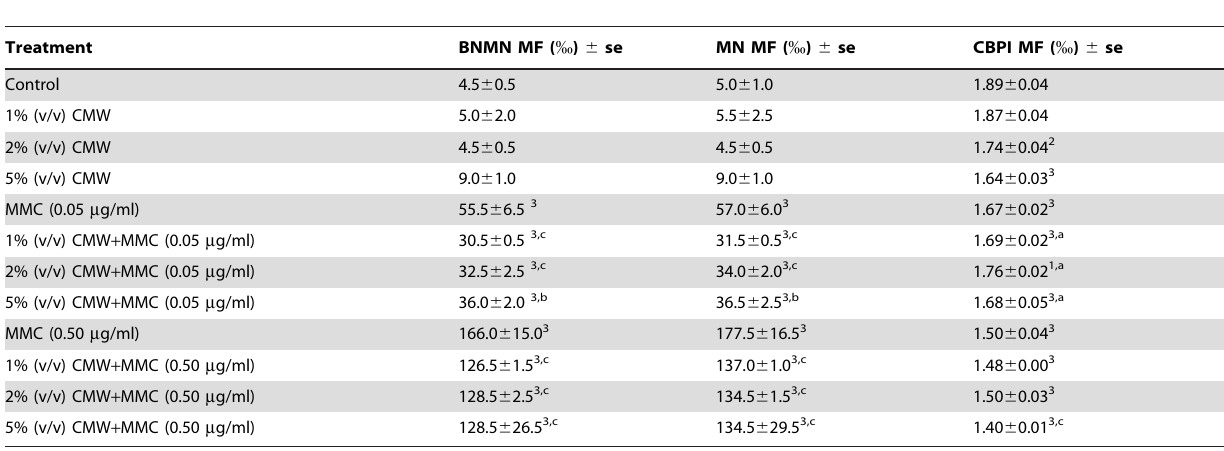
Table 1. Frequencies of BNMN and MN as well as CBPI values in cultured human lymphocytes treated with CMW, MMC (0.05 and 0.50 m g/ml) and their mixture.